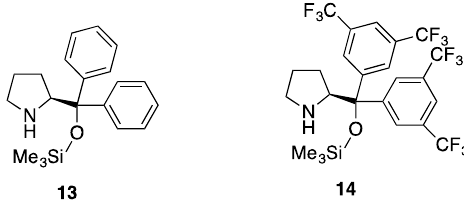
Figure 2. Jørgensen-Hayashi catalysts 13 (( S )-diphenylprolinol trimethylsilyl ether) and 14 Figure 2. (( S )-bis(3,5-trifluoromethylphenyl)prolinol trimethylsilyl ether) used in the enantioselective synthesis of pyrazolidinones 9 . Table 3. Enantioselective synthesis of pyrazolidin-3-ones 9 . Table 3. Enantioselective synthesis of pyrazolidin-3-ones 9